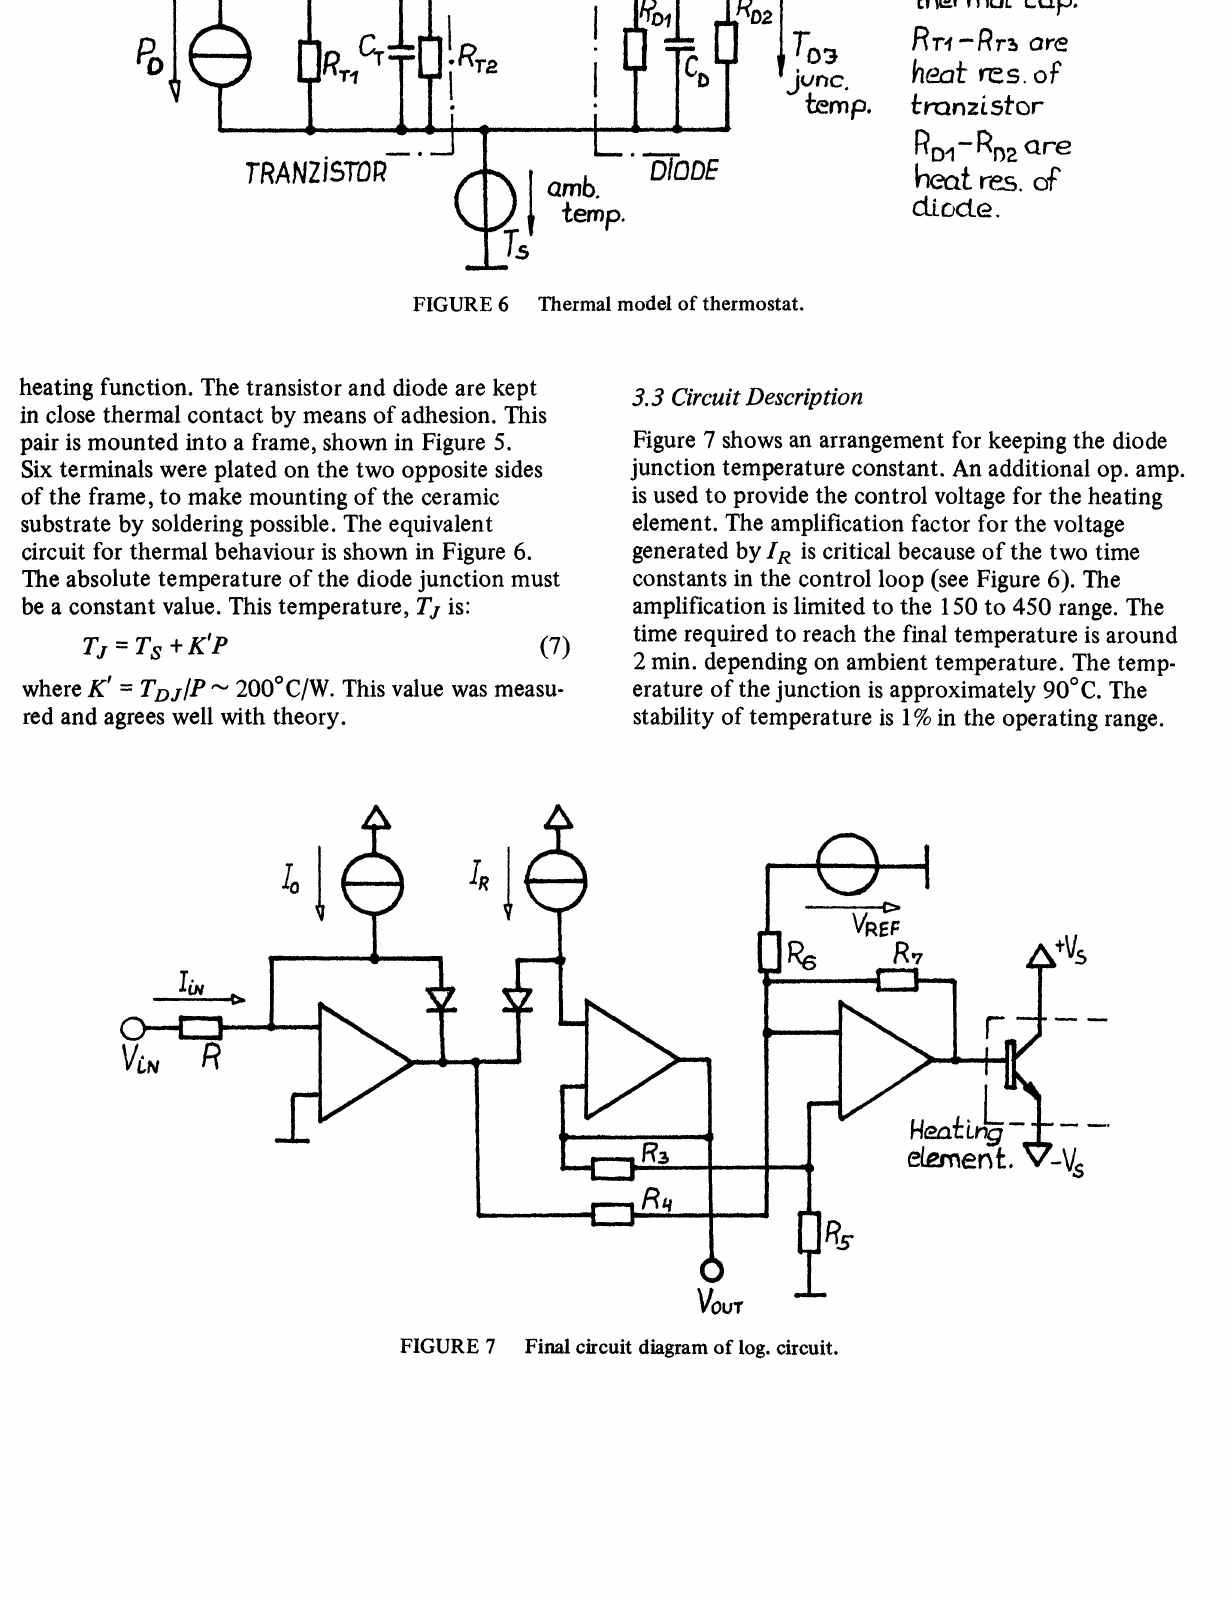
FIGURE 7 Final circuit diagram of log.